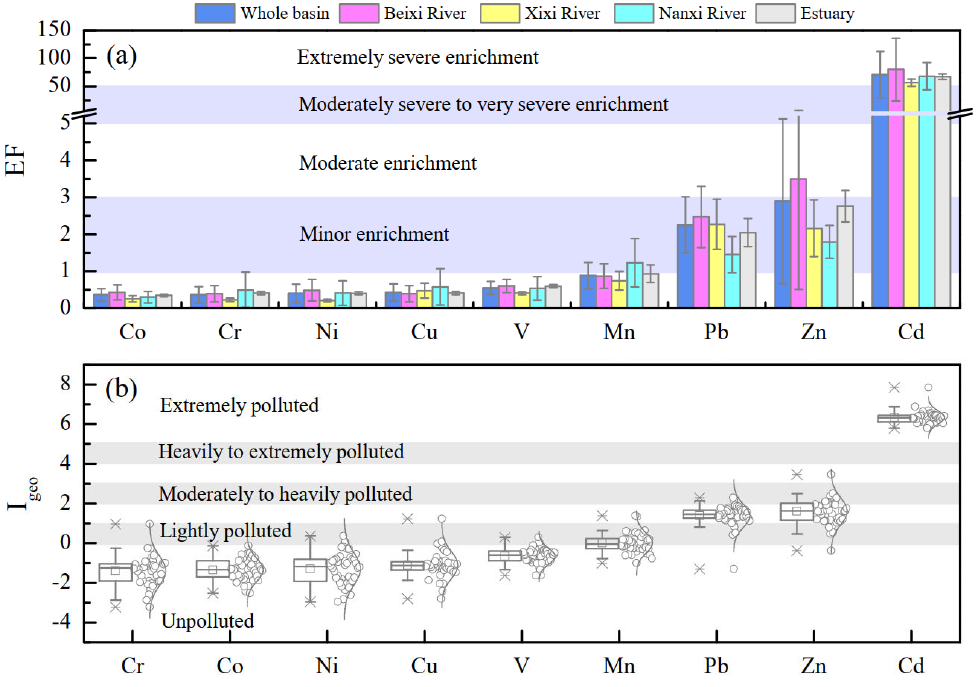
Figure 2. Enrichment factor ( a ) and geo-accumulation index ( b ) of particulate PTEs in JRB.